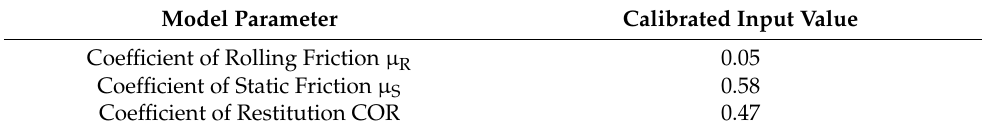
Table 1. Contact parameters for the DEM model.